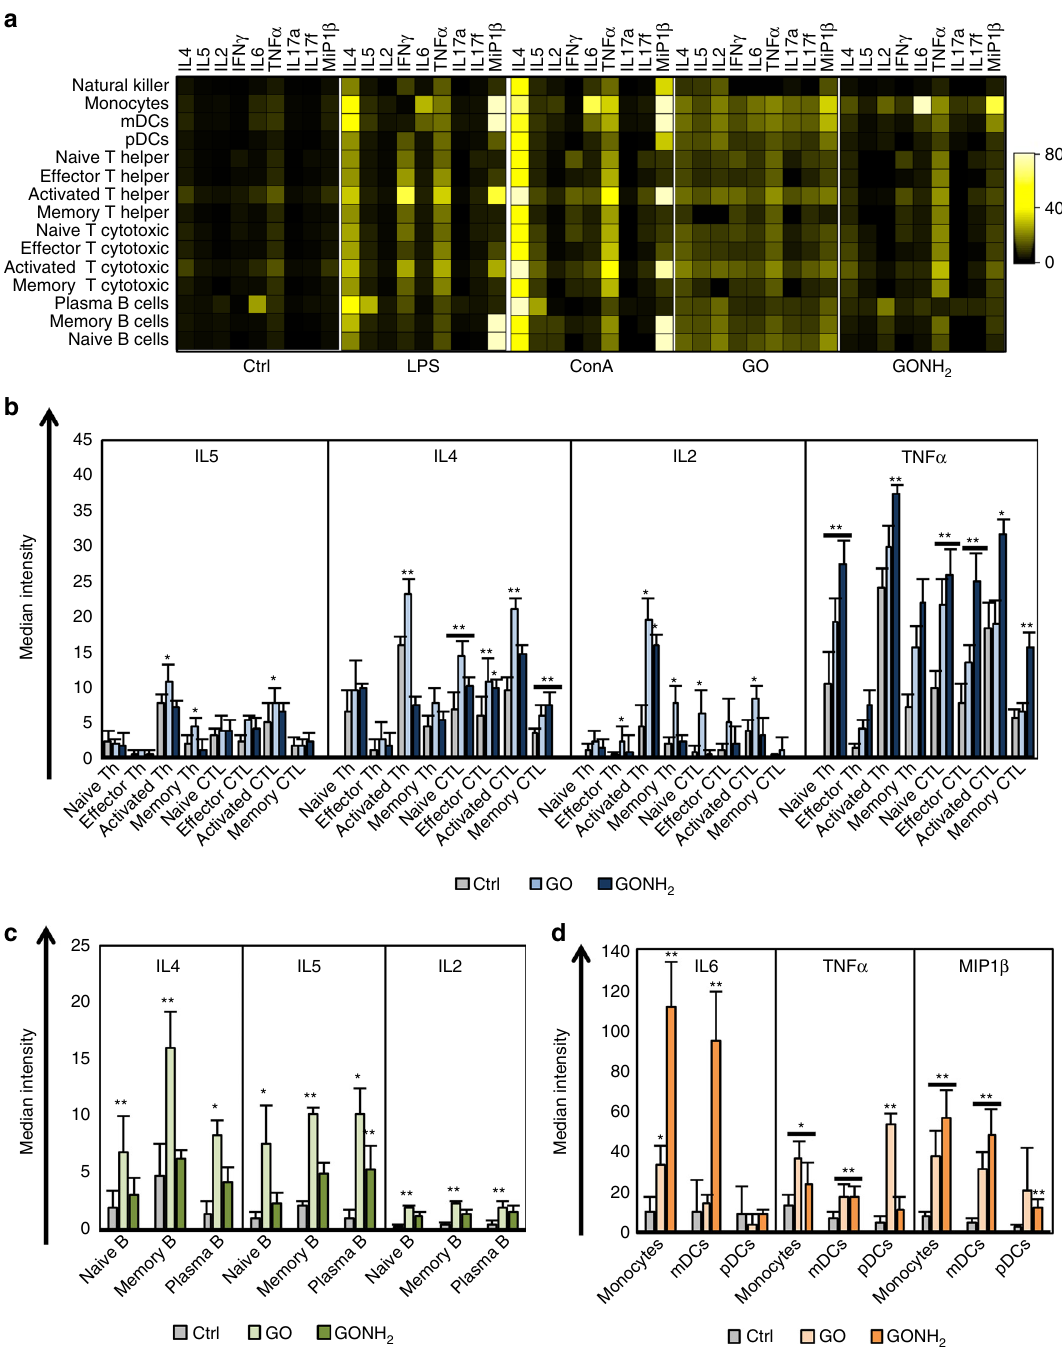
Fig. 2 Analysis of the immune cell behavior using CyTOF. PBMCs were treated with GO and GONH 2 at the concentration of 50 µ g ml − 1 labeled with markers of immune cell lineages and cytokines, detected with CyTOF2. a Heat map of median marker expression ratio for gated immune cell populations. Histograms of intracellular cytokine median expression. b IL4, IL5, IL2, and TNF α in T-cell subpopulations. c IL4, IL5, and IL2 median expression in B-cell subpopulations. d IL6, TNF α , and MIP1 β median expression in monocytes and mDCs. The analysis is made out of three experiments (* P -value < 0.05, ** P -value < 0.01 Statistical analysis performed by one-way ANOVA test between the median expression of each node into the boundaries compared with the